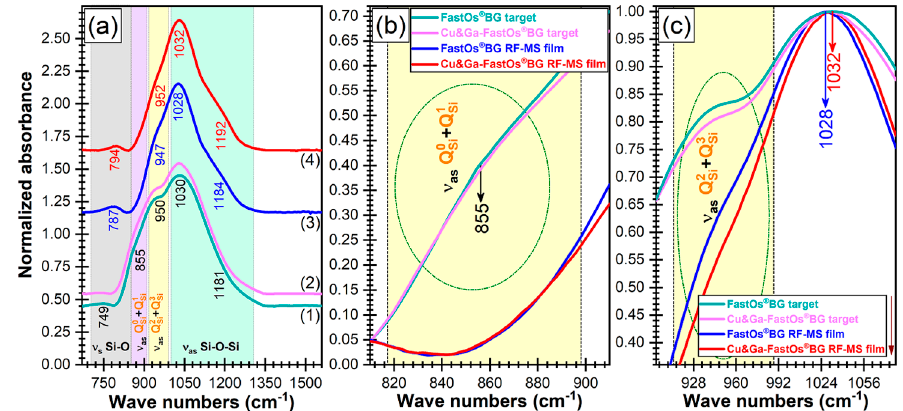
Figure 4. ( a ) FTIR spectra of the (1) FastOs ® BG and (2) Cu&Ga-FastOs ® BG melt-quenched glass powders, and (3) FastOs ® BG- and (4) Cu&Ga-FastOs ® BG-derived RF-MS layers; Insets highlighting the main structural modifications occurring in the spectral regions of the ( b ) ν as Q 0 + Q 1 and ( c ) ν as Q 2 + Q 3 vibration bands.